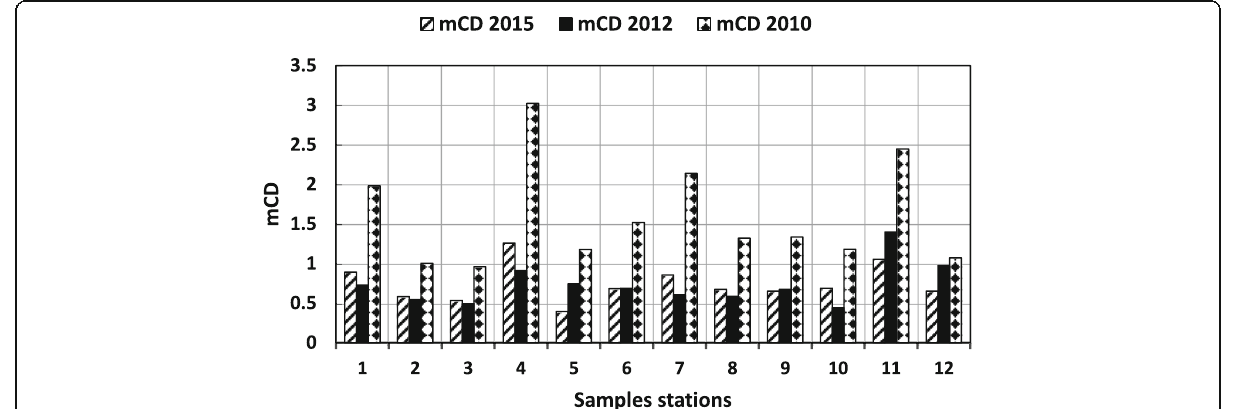
Fig. 4 Modified degree of contaminations (mDc) variations in 3 years. a Using this generalized formula to calculate the degree of contamination: mDc = ( ∑ Dc )/n. b Results show the degree of contamination in bottom sediments through different 3